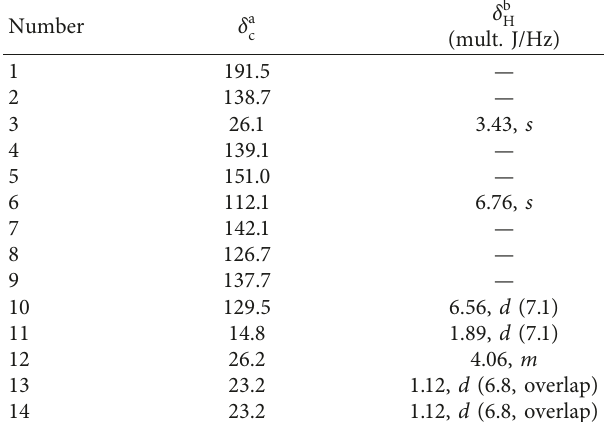
Table 1: 1 H and 13 C NMR data of compound 1